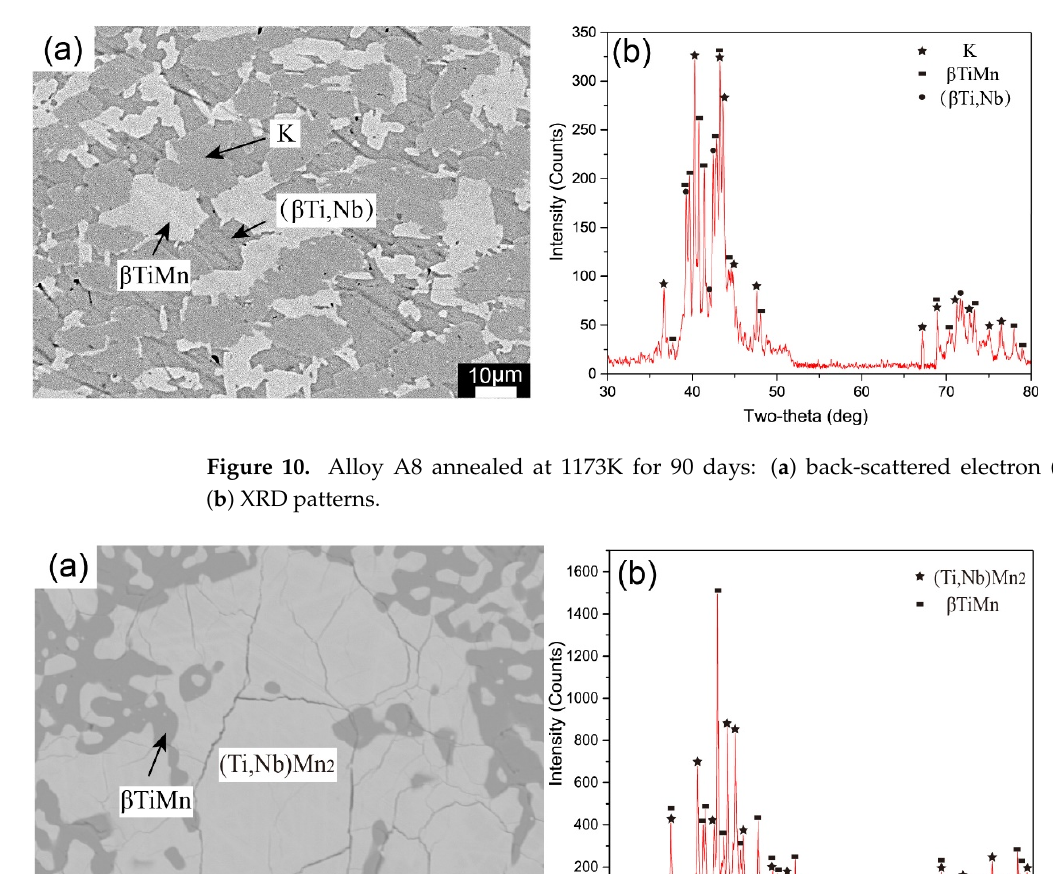
Figure 11. Alloy A12 annealed at 1173K for 90 days: ( a ) back-scattered electron (BSE) images, ( b ) XRD patterns.